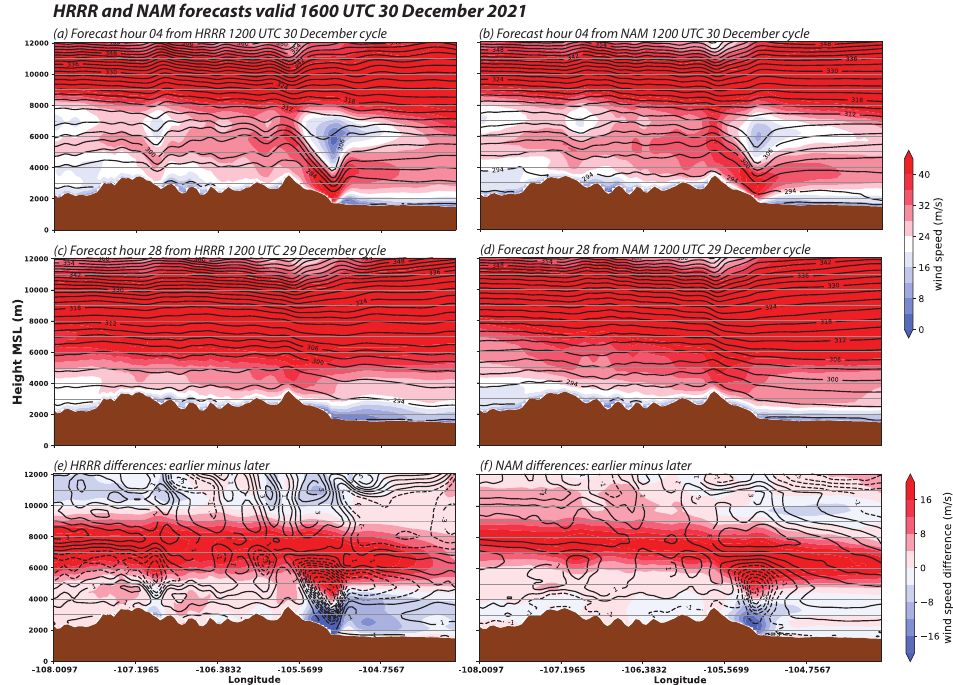
Figure 7. Similar to Figure 5 but showing HRRR (left column) and NAM (right column) forecasts valid 1600 UTC 30 December from the ( a , b ) 1200 UTC 30 December, and ( c , d ) 1200 UTC 29 December cycles, along with ( e , f ) difference fields (with 1 K potential temperature difference contours). NAM model fields were interpolated onto the HRRR model grid for